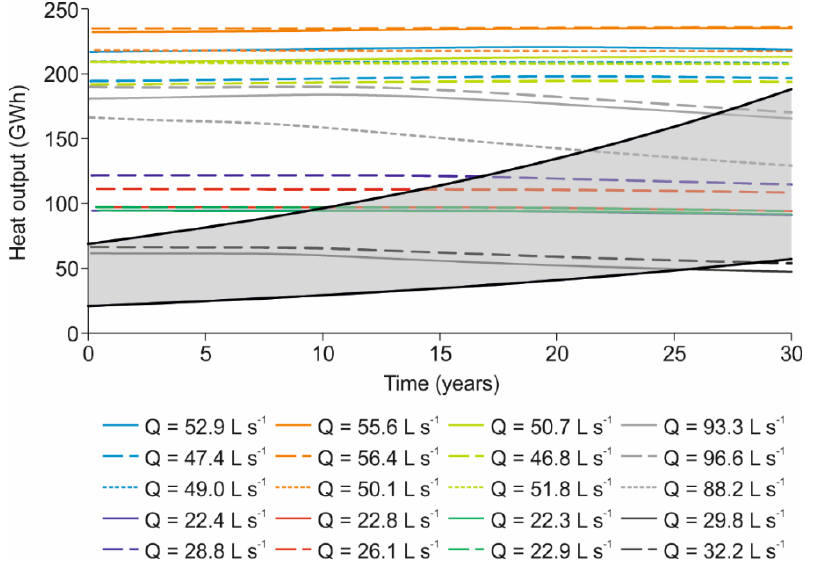
Figure 11. Heating energy produced (color lines) and projected demand (grey polygon). Lower bound of grey polygon—annual heating energy demand estimated based on Yan et al. [14], upper bound of grey polygon—annual heating energy demand estimated based on Gunawan et al. [15]. The reader is referred to Tables 4 and 5 for further details on the flow rates.